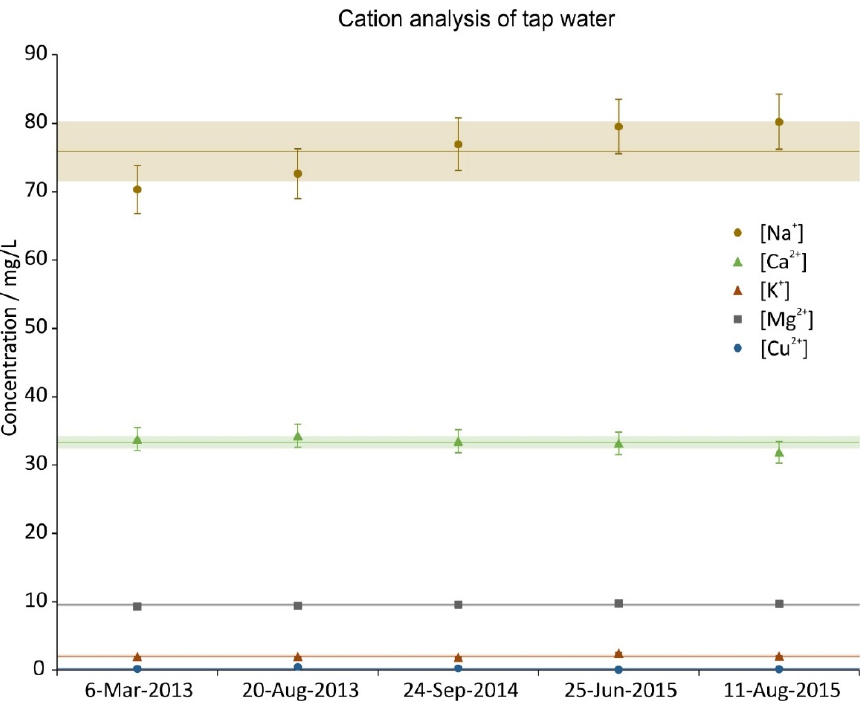
Figure 4. Cation concentration of 5 random tap water samples during the investigation period. The error bars show the precision of the measurement (5%), the lines are the averages and the shaded regions depict the standard deviations over the 5 samples.